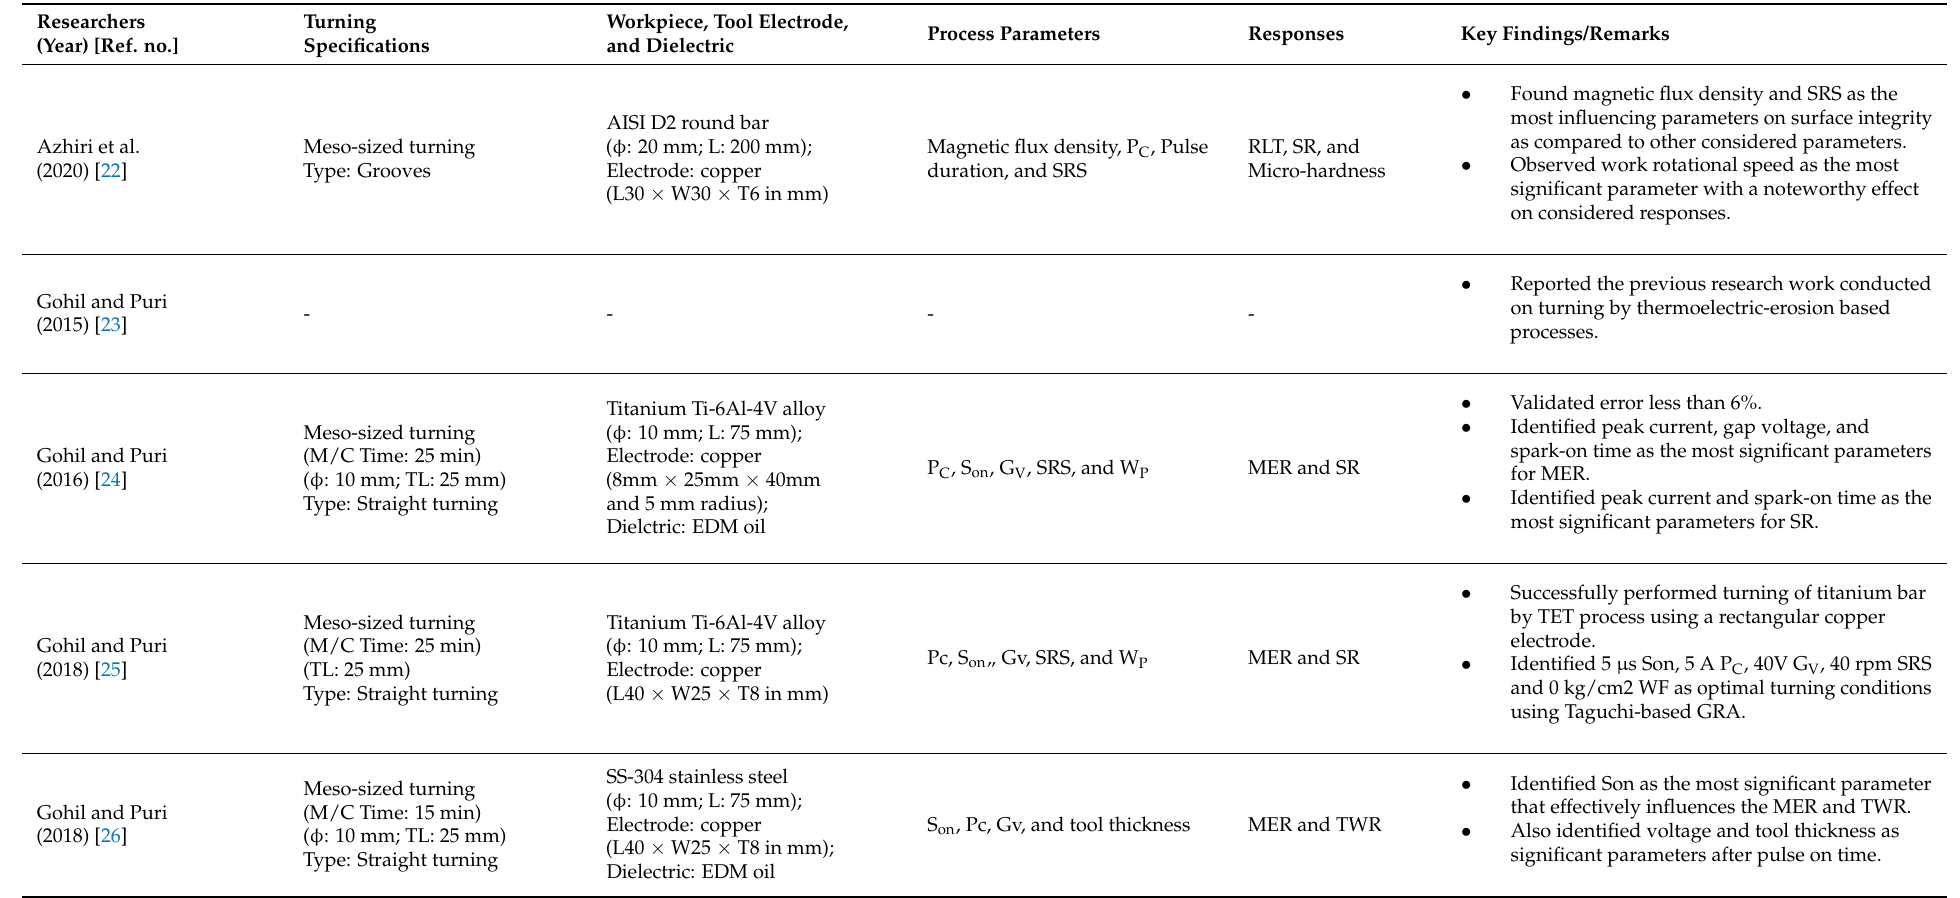
Table A1. Summary of the previous work on the fabrication of cylindrical and rotating parts by TET